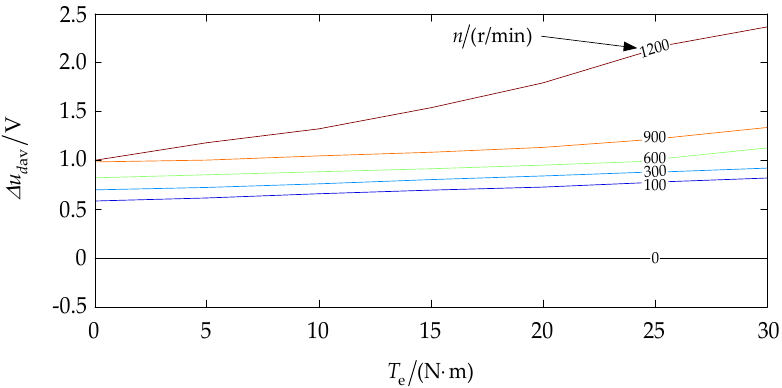
Figure 23. The variation curves of av d Δ u with the speed and the electromagnetic torque.